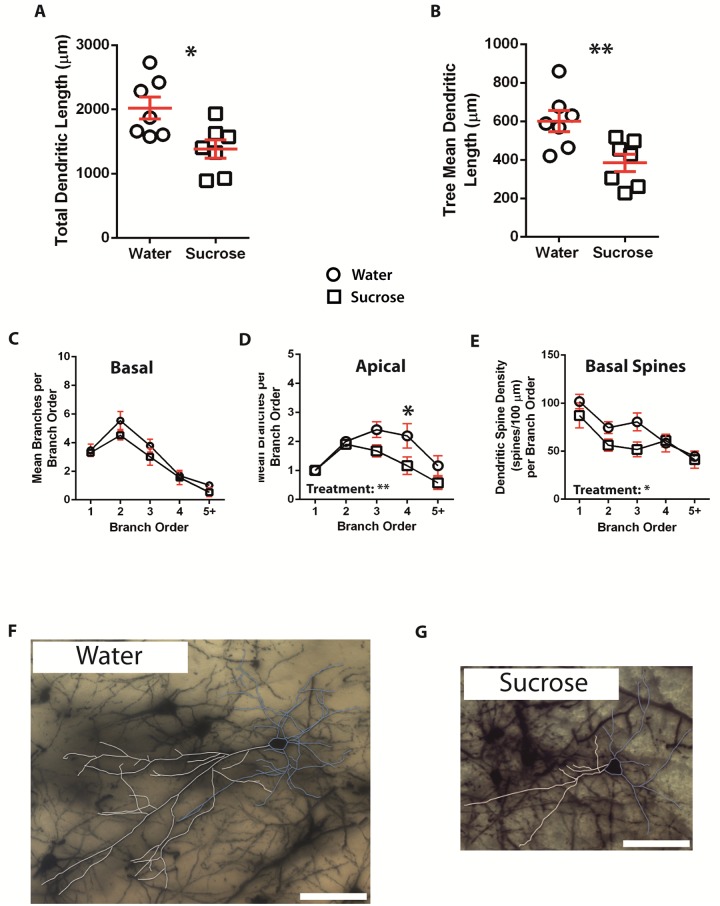
Decreased dendritic arbor length and distal branch number of principal neurons from the basolateral amygdala (BLA) of long-term sucrose consuming rats compared to control rats.A shows a scatter-plot of decreased total dendritic arbor (mean ± SEM) from the BLA in long-term sucrose rats (open squares) compared to controls (open circles) (Unpaired two-tailed Students t-test,*P < 0.05, n = 7; control and n = 7; 12 week sucrose). B shows a scatter-plot of decreased mean dendritic tree length (mean ± SEM) from the BLA in long-term sucrose rats (squares) compared to controls (circles) (Unpaired two-tailed Students t-test, **P < 0.01, n = 7; control and n = 7; 12 week sucrose). Branch order analysis (mean ± SEM) showing no change in the number of dendritic segments for basal dendrites (C), but decreased dendritic segment number for apical dendrites from sucrose drinking rats (square) compared to water controls (triangles) (D, two-way ANOVA). E shows decreased dendritic spine density per branch order for basal dendrites from long-term sucrose rats compared to controls (two-way ANOVA). Bonferroni post-tests revealed a significant reduction in the apical segment number at distal 4th order branches in long-term sucrose consuming rats compared to controls (D) (two-way ANOVA with Bonferroni post-tests,*P < 0.05, n = 7; control and n = 7; long-term sucrose). F and G show representative brightfield z-stack mosaics of Golgi-Cox impregnated principal neurons from the BLA (63x magnification) of control (water) and long-term (12 week) sucrose drinking rats respectively. Scale Bars: (F, G) = 100 μm.